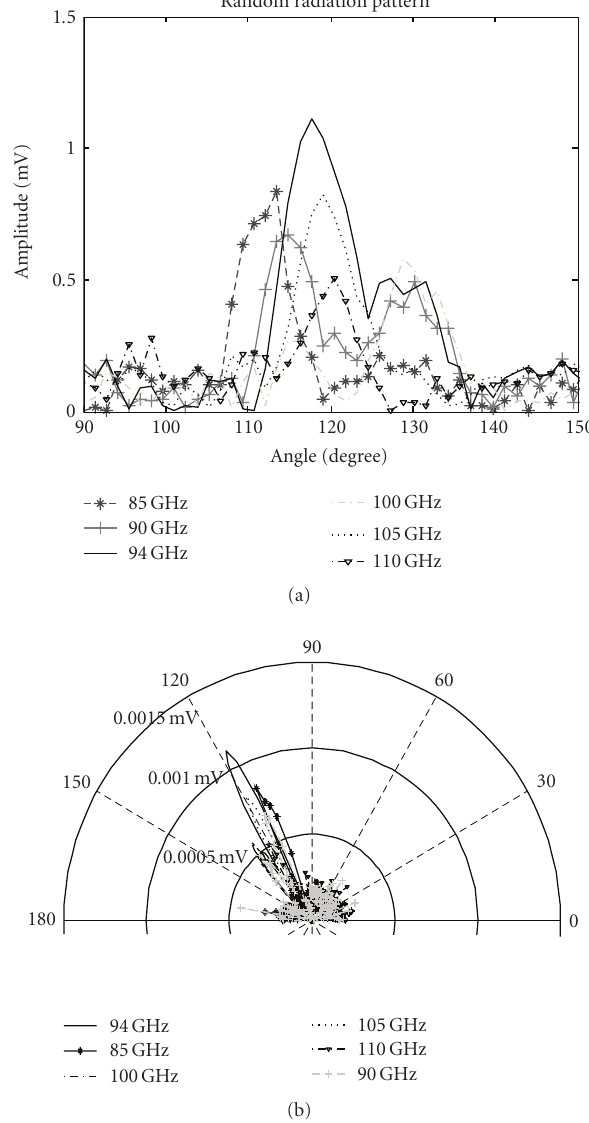
Figure 7: Measured near field radiation pattern of random phase di ff user: (a) rectangular plot (b) polar